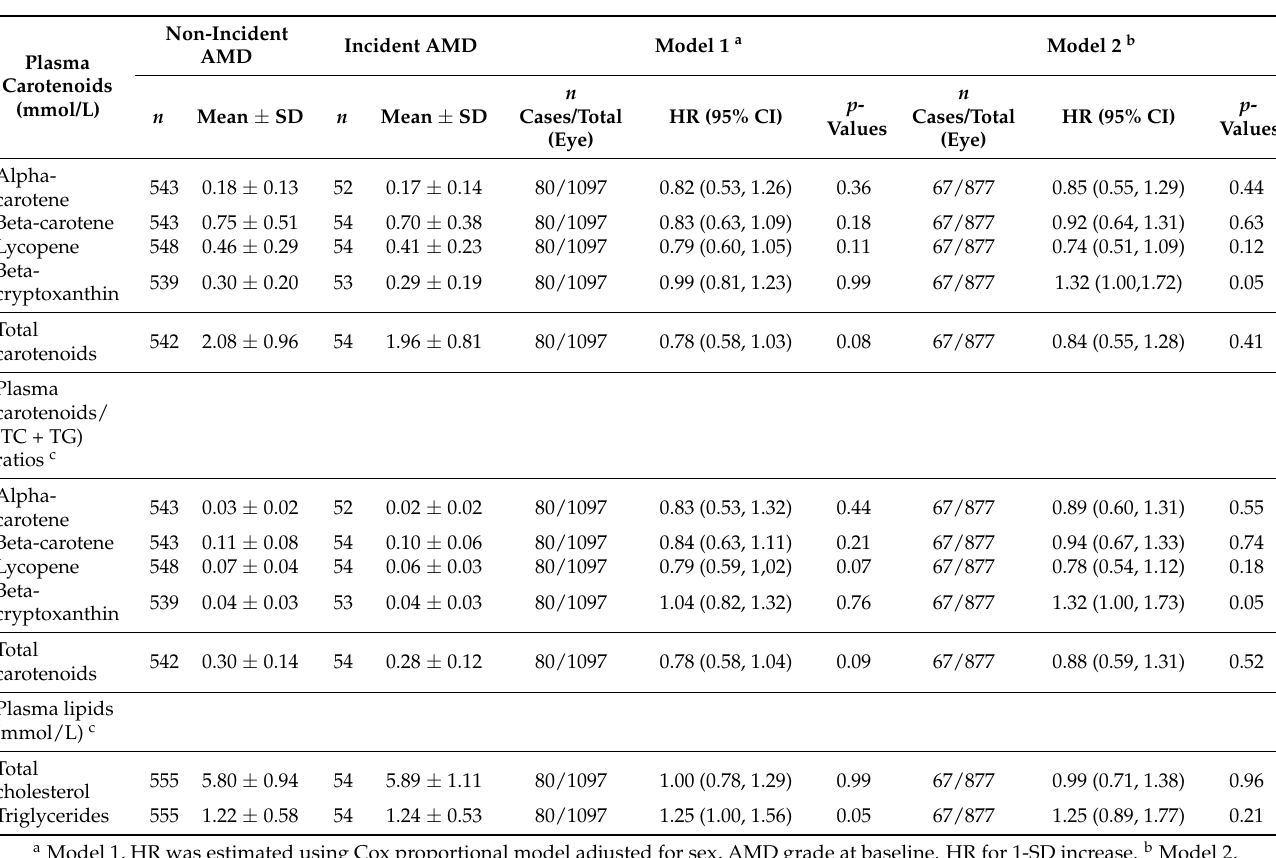
Table 4. Associations between other plasma carotenoids and carotenoids/(TC + TG) ratios and incidence of advanced age-related macular degeneration. Alienor study, 2006–2017.